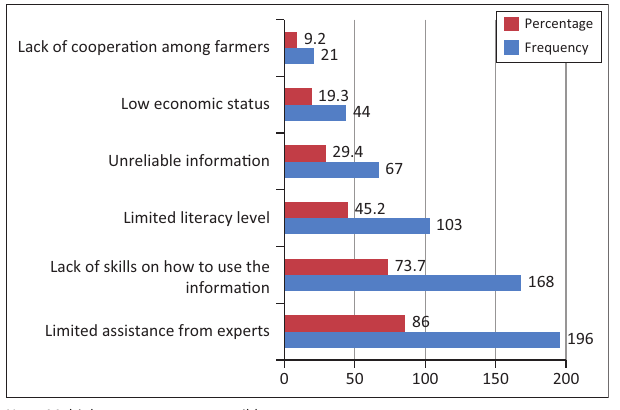
FIGURE 2: Factors that hinder the use of poultry management information ( N =